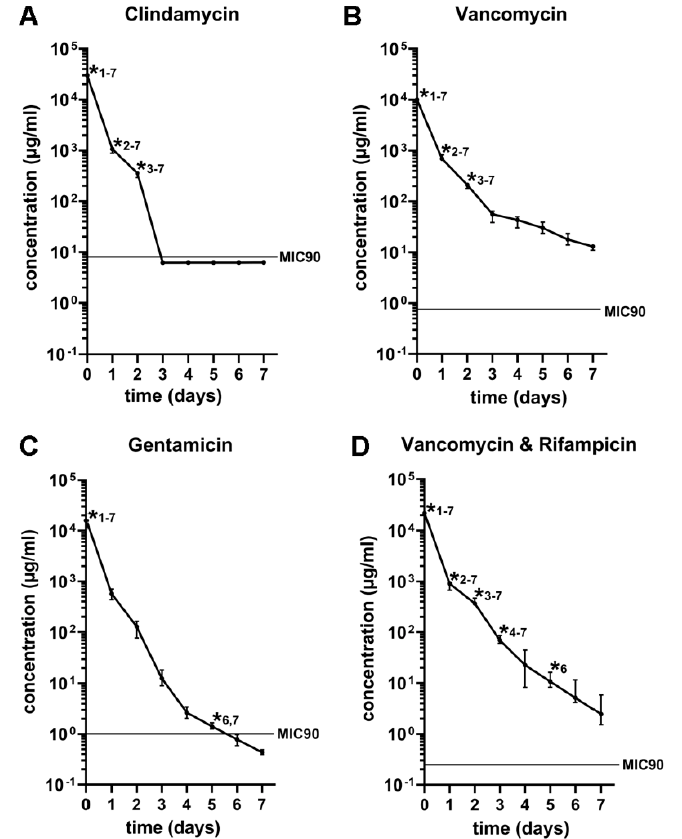
Figure 2. In vitro release kinetics of allogenic bone blocks loaded with antibiotics up to seven days after incubation in clindamycin ( A ), vancomycin ( B ), gentamicin ( C ), and vancomycin in combination with rifampicin ( D ). The concentration of vancomycin and vancomycin in combination with rifampicin, gentamicin, and clindamycin in the bone blocks was above the MIC90 for seven, five, and two days respectively. Significant differences ( p ≤ 0.05) compared to other time points are marked with a star (*) and the associated time point.